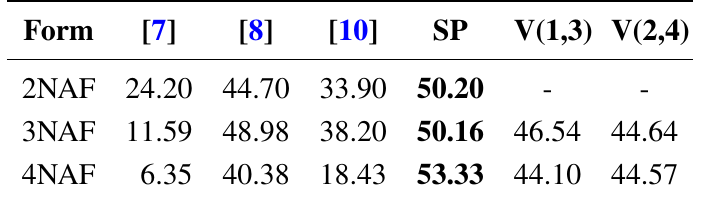
Table 5. Average percentage (%) of zero occurrences for a 160-bit scalar, tested using random number vectors from Blum-Blum-Shub (Lim and Lee use a normal representation) , SP: speed-optimized model; V(1,3): size-optimized model in the case